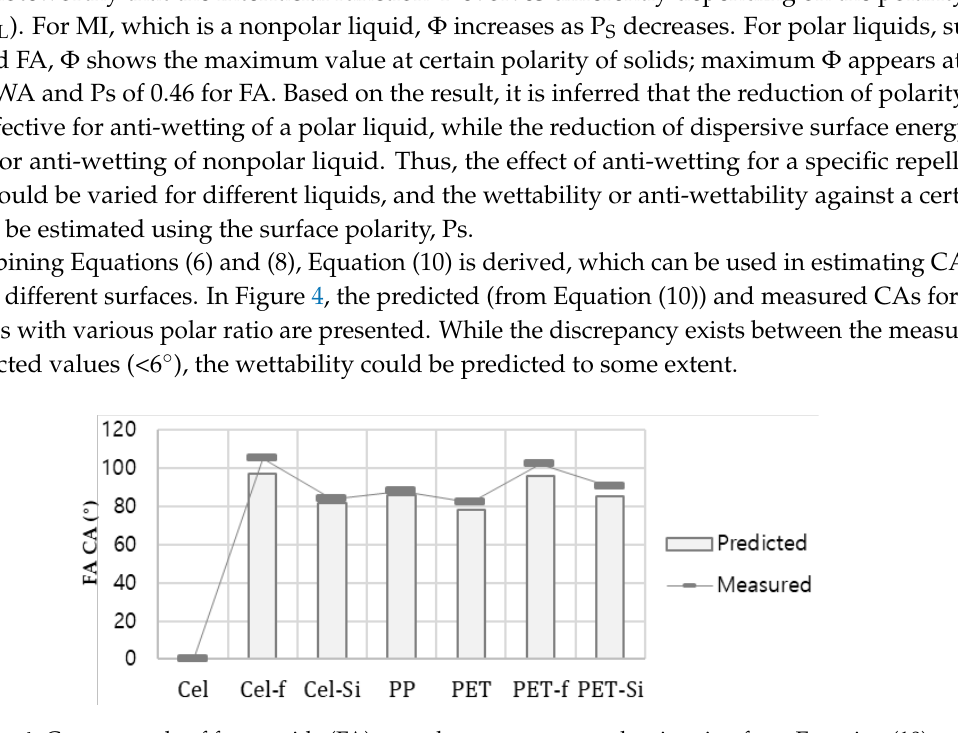
Figure 3. Surface polarity influencing wetting. ( a ) Percentage of the polar contribution to the overall surface energy of solids; ( b ) Interfacial function with % polarity.